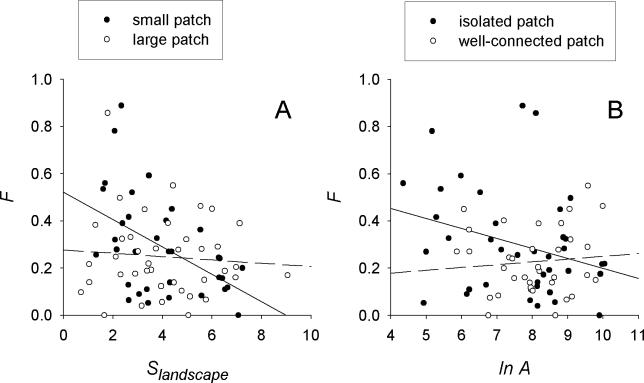
Pattern of
Pgi Differentiation among Populations
The value of
Pgi genotype frequency
F in relation to landscape connectivity (A) and habitat patch area (B). Closed (continuous line) and open symbols (broken line) in (A) represent habitat patches smaller or greater than 0.3 ha and in (B) isolated (
S
landscape < 3) and well-connected patches, respectively. A model with ln
A, S
landscape, and their interaction explains 14% of variation in
F (
F = 5.00,
p = 0.003,
n = 73). The ln
A * S
landscape interaction (
t = 2.54,
p = 0.01) and the main effects of ln
A (
t = −2.95,
p = 0.004) and
S
landscape (
t = −2.84,
p = 0.006) are all significant. The effects of ln
A, S
landscape, and ln
A * S
landscape were also significant in a model including all populations regardless of their size but weighting the regression with the average population size for the years 1994–1996 (
F = 3.24,
p = 0.02,
n = 324; the
p-values for the coefficients were 0.02, 0.01, and 0.03, respectively).